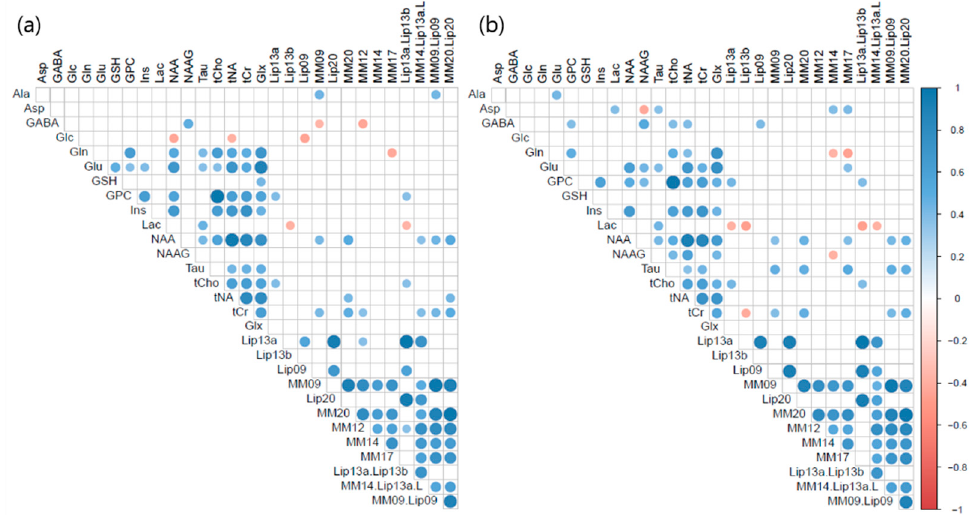
Figure 4. Correlation matrices of metabolite and macromolecule concentrations. Left, quantified by the in-house experimental basis set ( a ); Right, quantified by the provided simulated basis set ( b ).